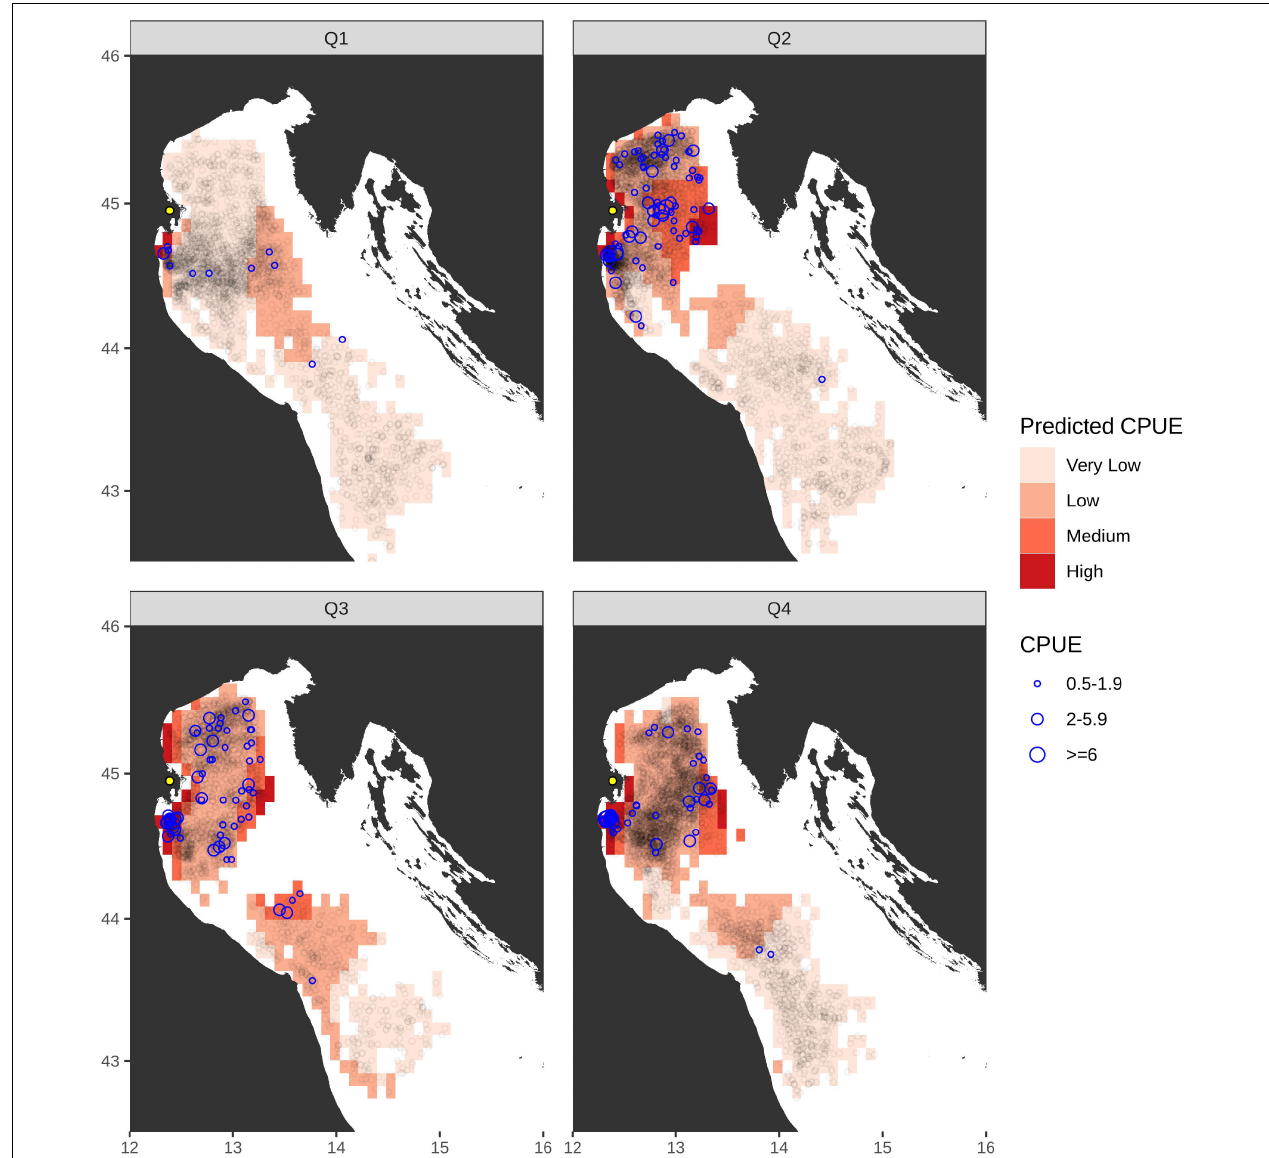
FIGURE 2 | Distribution of predicted CPUEs aggregated at quarterly base using a spatial grid with cell of 0.09 ◦ (about 10 km). The predicted CPUEs are showed using tiles with a color a red gradient from light red (very low) to dark red (high). The observed CPUEs are represented with blue circles and their size indicates the magnitude. Position of fishing hauls with zero catches are represented with black circles. The River Po delta is illustrated with a yellow